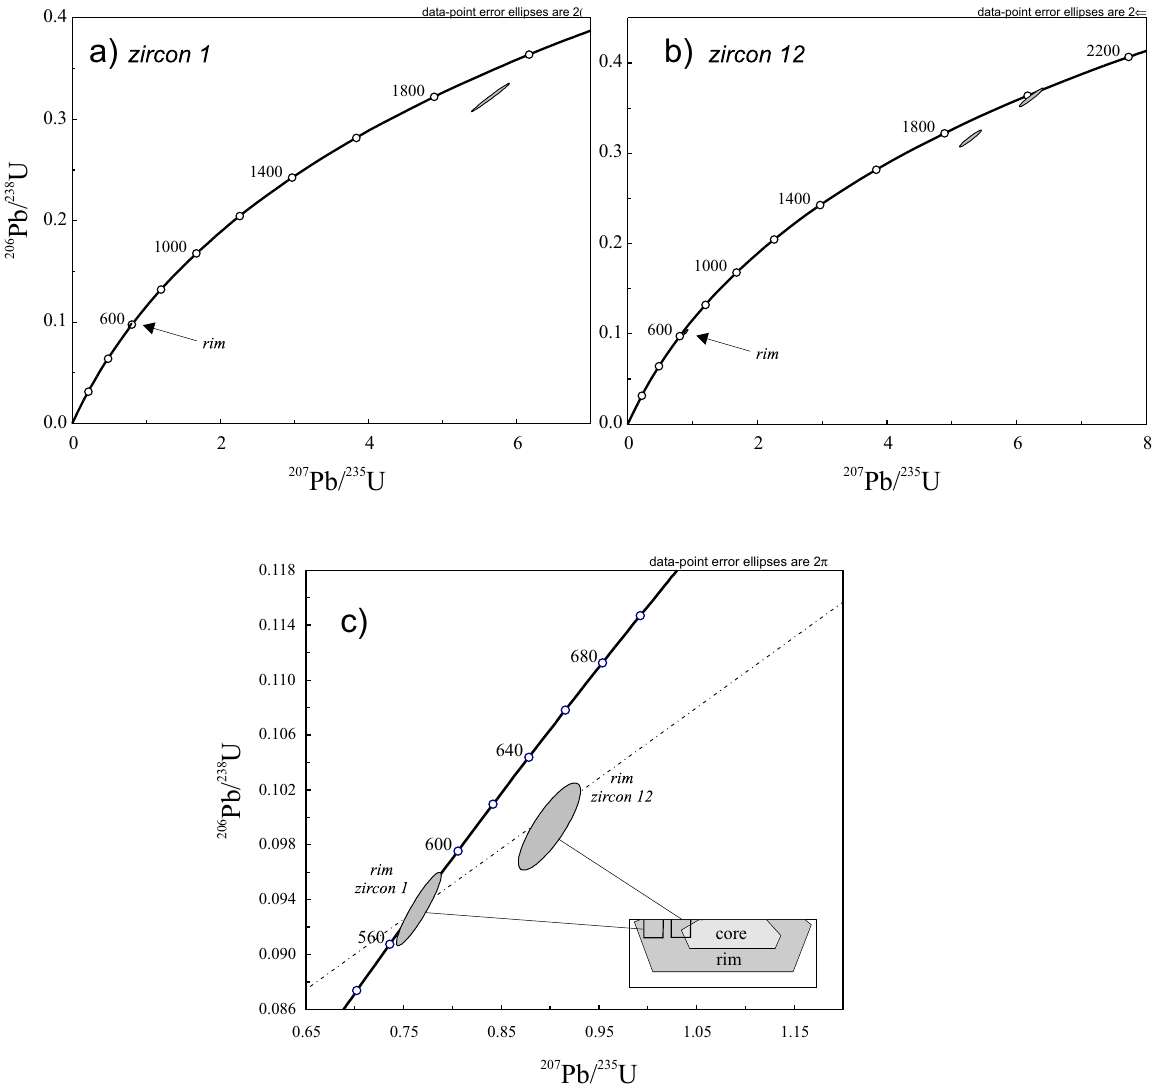
Fig. 4 – a-b) Concordia diagrams showing the U-Pb results obtained for the two selected zircons from the studied migmatite rock. c) Detail of the lower intercept portions, showing the rim compositions of both analyzed zircons. In the frame an analytical interpretation for discordant characters of one of these analyses is showed (see text for